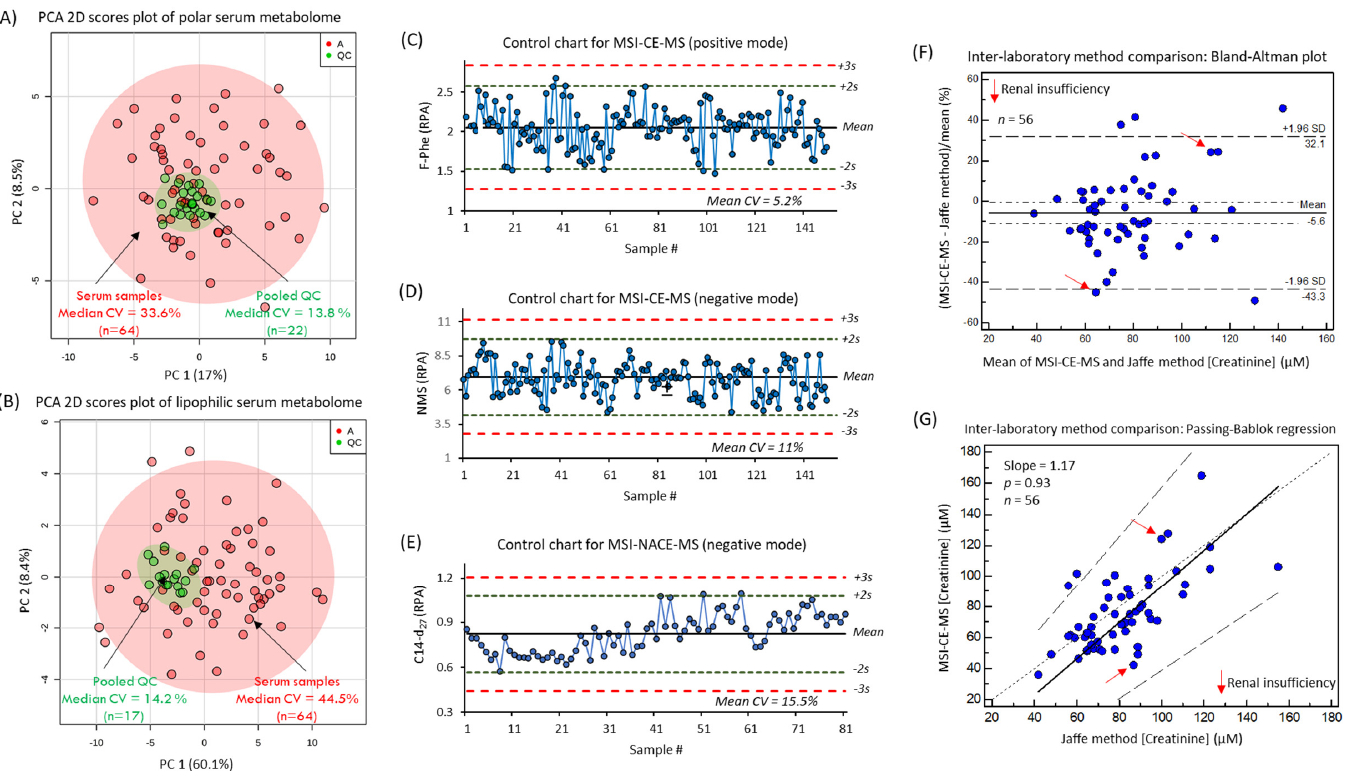
Figure 2. Two-dimensional scores plot from the principal component analysis (PCA) of the glog -transformed and autoscaled serum metabolome data used to compare the intersubject biological variance relative to the technical variance from the repeat analysis of pooled serum QC samples for ( A ) the hydrophilic serum metabolome and ( B ) the lipophilic serum metabolome. Control charts for ( C ) the recovery standard (F-Phe) measured under aqueous positive ion mode, for ( D ) the recovery standard 2-napthalenesulfonic acid (NMS) measured under aqueous negative ion mode, and for ( E ) the recovery standard 14-d27 measured under nonaqueous negative ion mode for all serum and QC samples demonstrate acceptable precision ( CV = 5.2–15.5%) with no outliers exceeding the warning limits ( ± 3 s). ( F ) Bland–Altman percent difference plot for comparing the mutual agreement between the serum creatinine concentrations measured independently by MSI–CE–MS and Jaffé colorimetric methods at two different laboratories from 56 participants. Overall, the data are randomly distributed with a modest mean bias of –5.6% with four outliers outside agreement limits. ( G ) A Passing–Bablok regression analysis demonstrates no significant deviation (dotted lines; 95% confidence interval) from the line of equality ( p > 0.05) with a slope of 1.17 (black line; regression line).